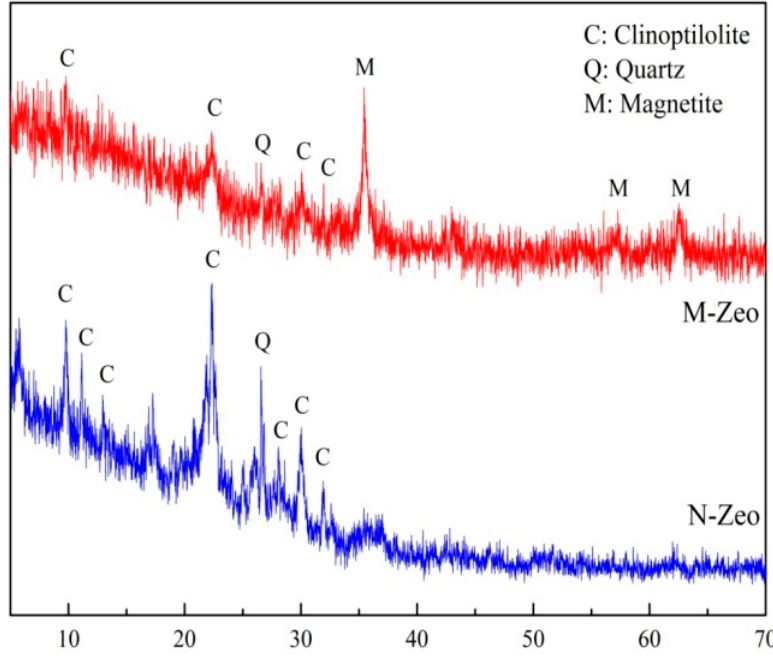
Figure 1. XRD patterns of the N-Zeo and M-Zeo.